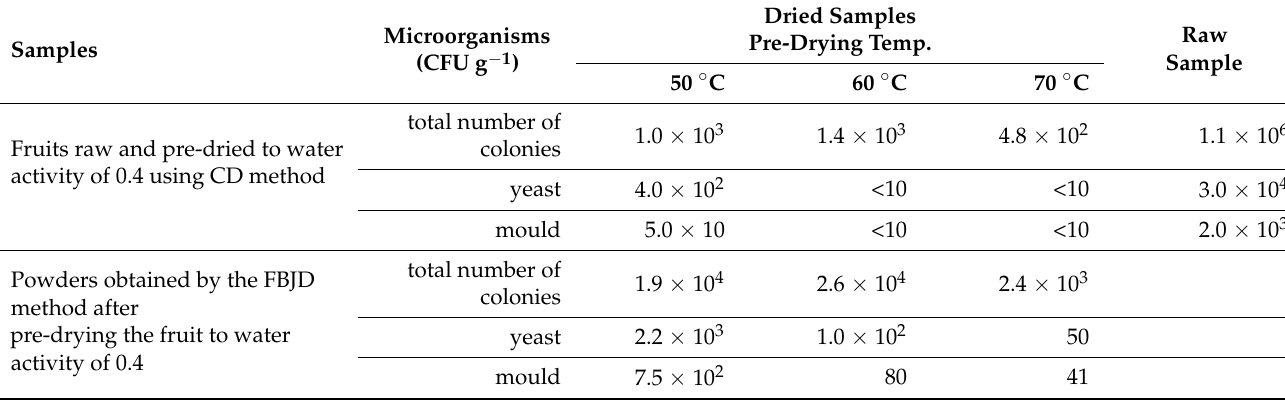
Table 2. Total number of colonies and amounts of yeast and mould in whole chokeberry fruits and after initial pre-drying at different temperatures (50, 60, and 70 ◦ C) and in powders obtained by the FBJD method after pre-drying fruit at and in those the same